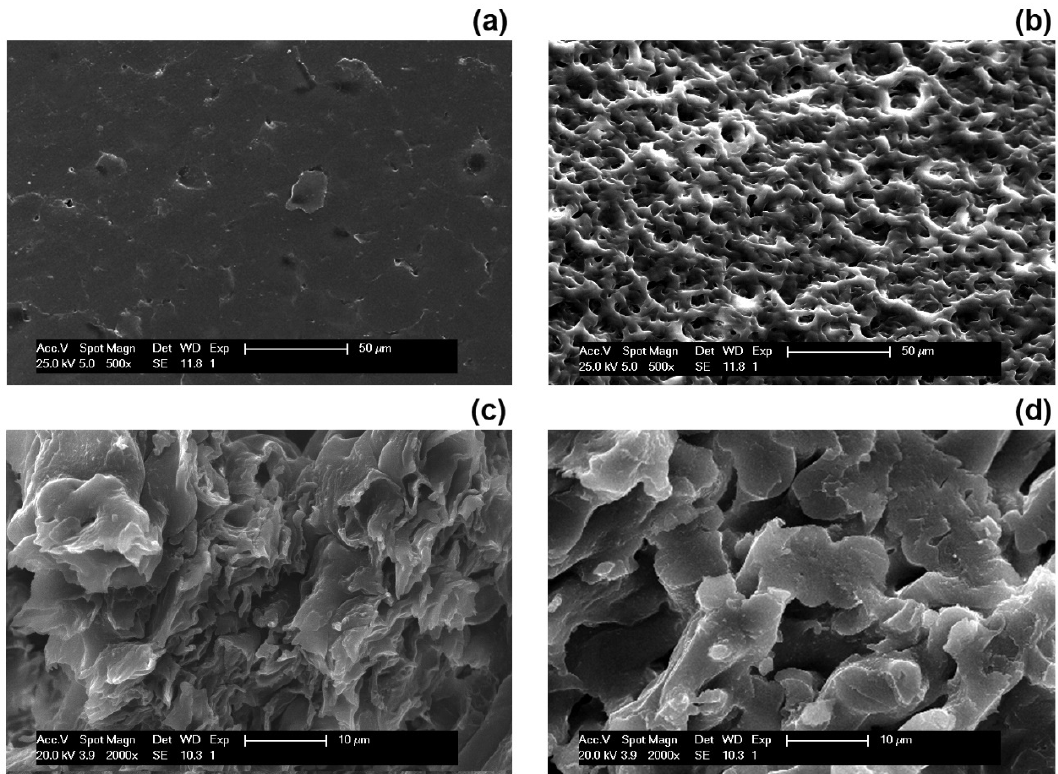
Figure 5. Scanning electron microscopy (SEM) images of surfaces and cross-sections of zein-LBA films before and after LBA release: surface ( a ) before extraction, ( b ) after extraction; cross-section ( c ) before extraction, ( d ) after extraction. Scale bars: 50 µm for ( a ) and ( b ); 10 µm for ( c ) and ( d ).